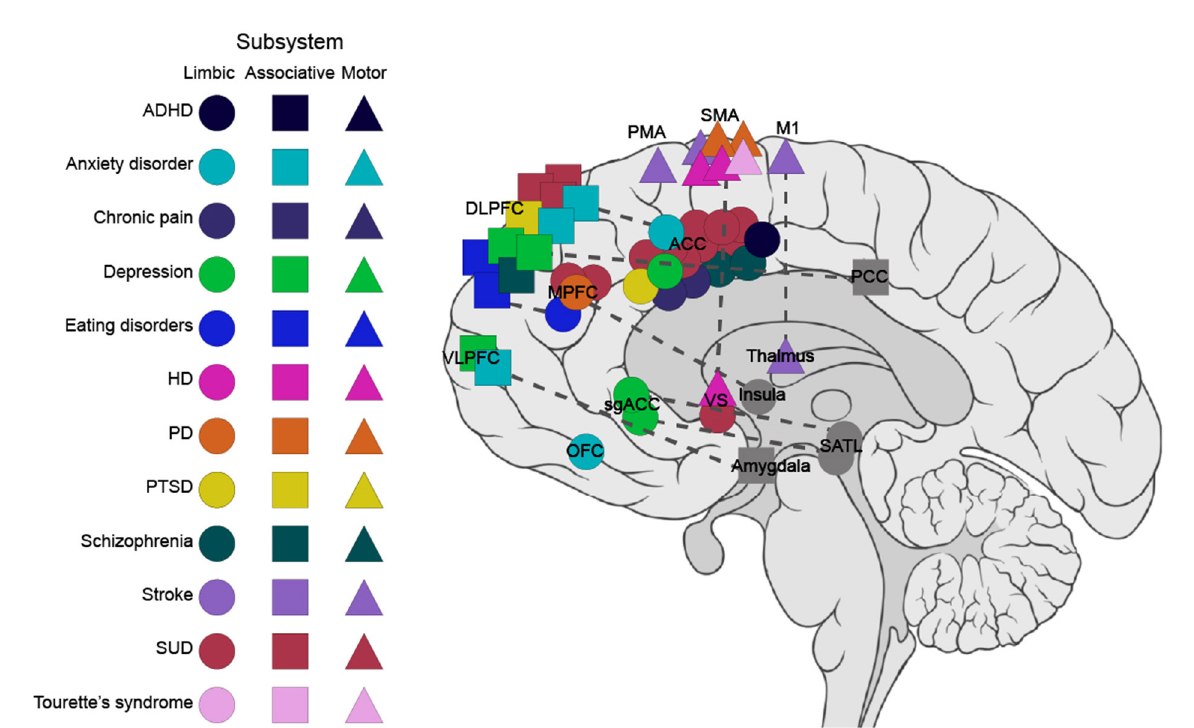
FIGURE4 Targets within the frontostriatal circuitry (FSC) for fMRI-based NF in clinical populations. This graph depicts the targeted regions within the FSC for the three subsystems. The circle, square, and triangle refer to the regions in limbic, associative, and motor subsystems, respectively. The dashed line represents connectivity feedback. Regions outside the FSC with connectivity feedback to FSC regions are marked in gray. ACC, anterior cingulate cortex; ADHD, attention deficits hyperactivity disorder; DLPFC, dorsolateral prefrontal cortex; HD, Huntington’s disease; IFG, inferior frontal gyrus; M1, primary motor cortex; MPFC, medial prefrontal cortex; OFC, orbitofrontal cortex; PCC, posterior cingulate cortex; PD, Parkinson’s disease; PMA, premotor area; PTSD, post-traumatic stress disorder; SATL, superior anterior temporal lobe; sgACC,